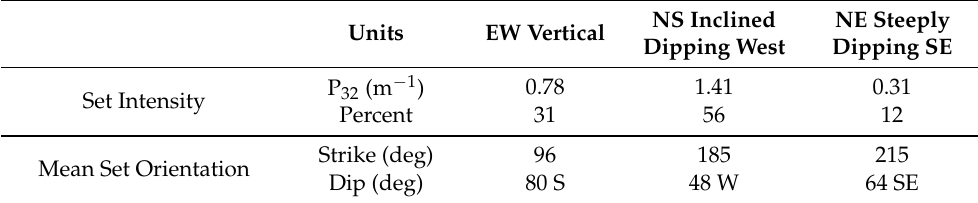
Figure 5. Contour plots of 58-32 FMI fracture poles in upper hemisphere: equal area stereonets showing the relative intensities before bias correction ( a ) and after applying Terzaghi weighting ( b ). Table 1. Fracture set orientations and intensity from Well 58-32 FMI data. Intensity data are based on the Terzaghi weighted distribution. P 32 is defined as the total fracture area per unit